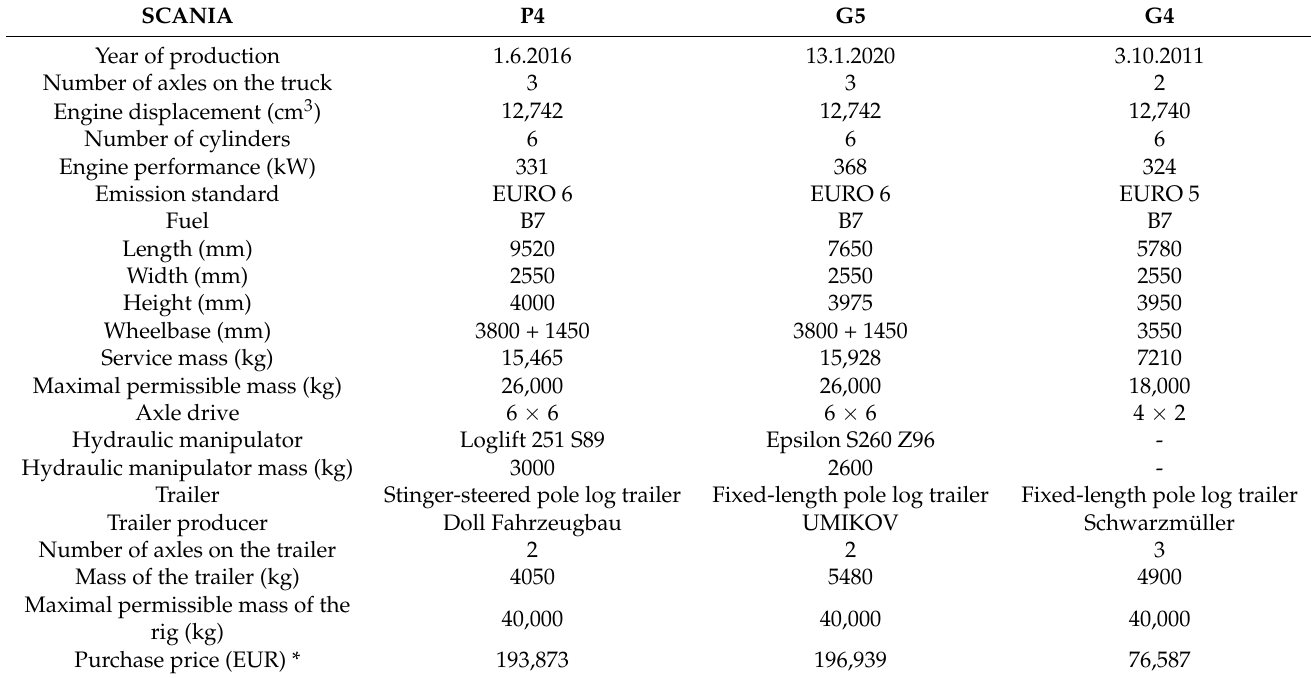
Table 1. Technical parameters of the observed logging